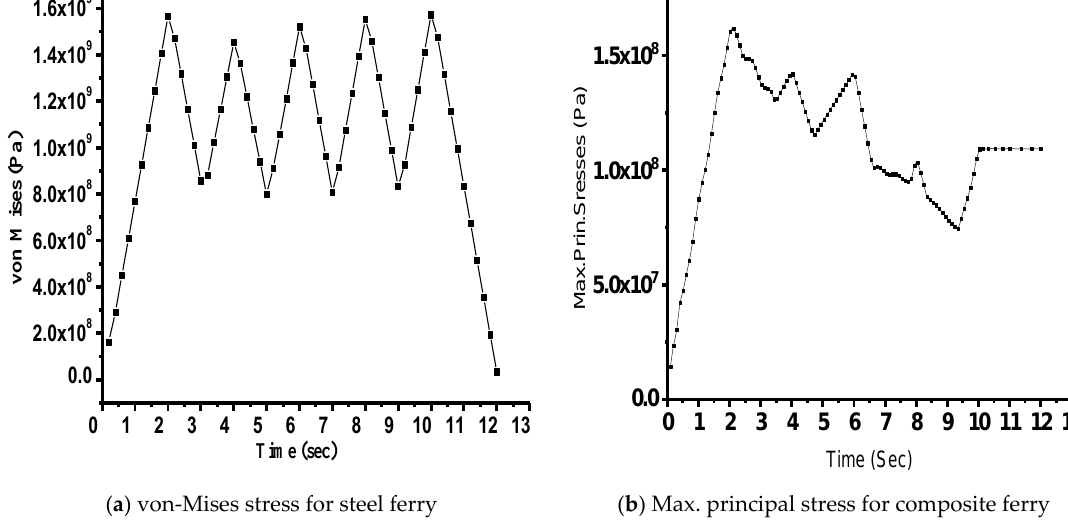
Figure 30. Stresses change with time for case 3.